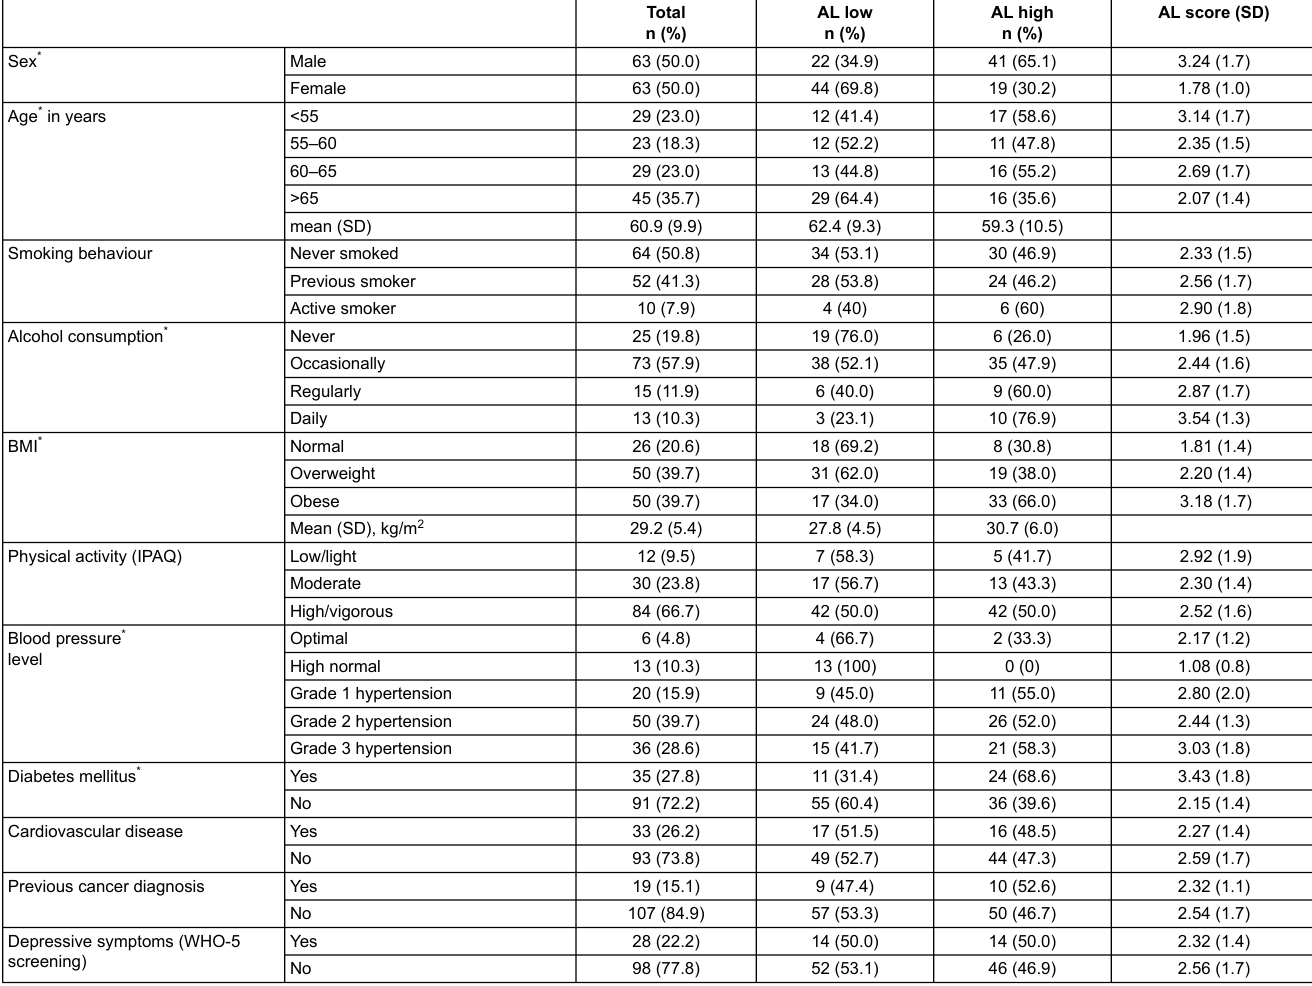
Table 2: Health-related sample characteristics (n = 126) by allostatic load (AL) group, and the continuous AL